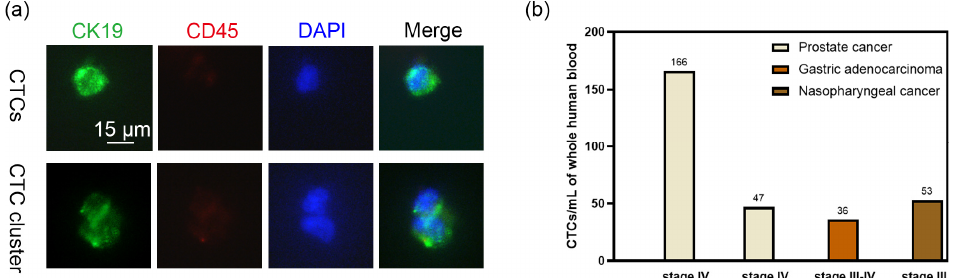
Figure 6. Identification of CTCs and cluster from tumor patients. ( a ) Representative immunofluo- rescence images of isolated CTCs and cluster. CTCs and CTC cluster were stained with cytokeratin 19 (green), CD45 (red) and DAPI (blue). Scale Bar = 15 µ m. ( b ) The number of captured CTCs per milliliter of whole blood for each tumor